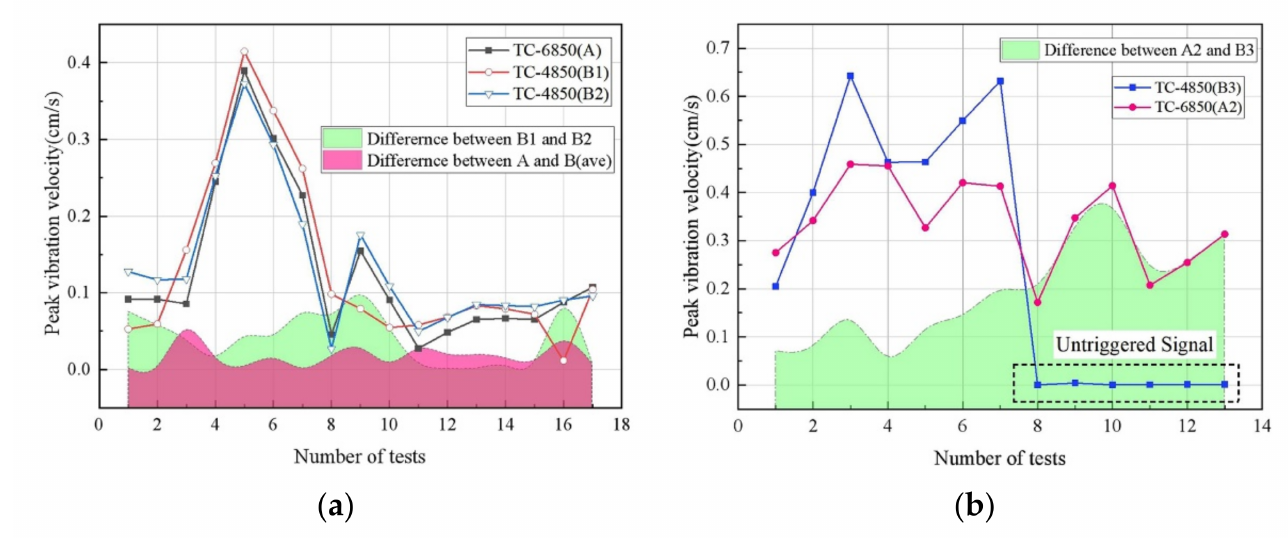
Figure 6. ( a ) The comparison of monitoring data between TC-4850 and TC-6850 on the ground. ( b ) The comparison of monitoring data between TC-4850 and TC-6850 on the building.